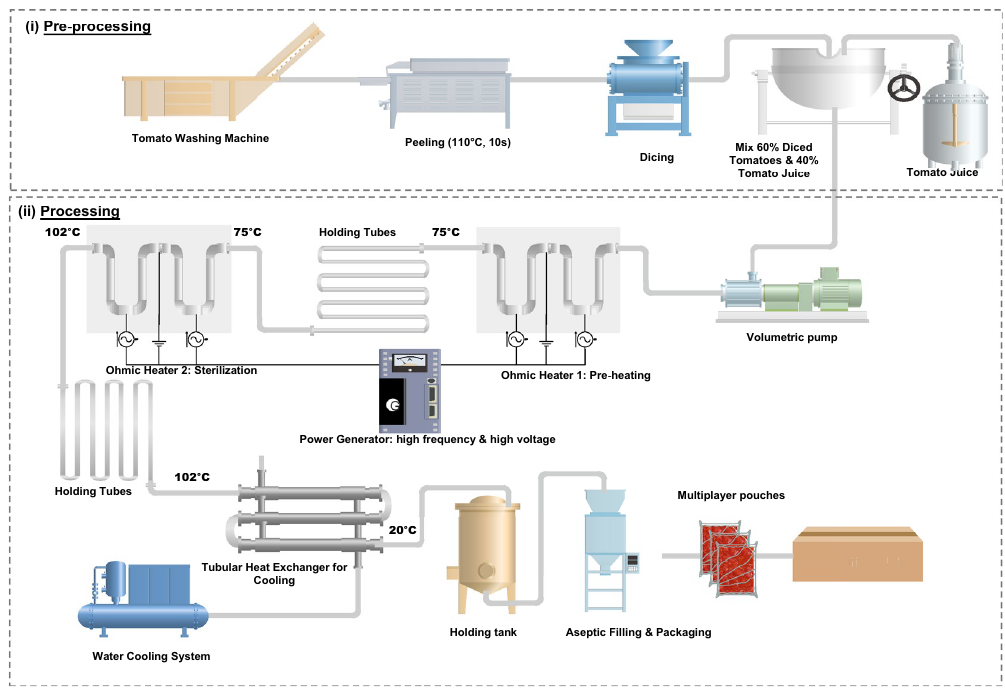
Figure 2. Aseptic Ohmic heating line with 4 t/h capacity, including pre-processing, preheating, sterilization, cooling and aseptic